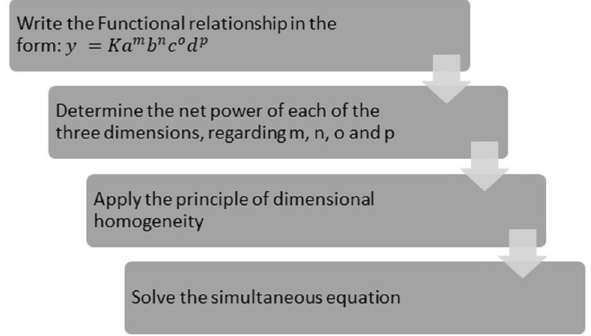
Fig. 1 Rayleigh’s